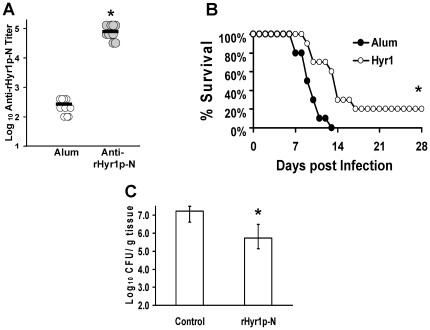
rHyr1p-N vaccine prolonged survival and decreased fungal burden in neutropenic mice infected with C. albicans.Balb/c mice (n = 20 per arm) were vaccinated with rHyr1p-N mixed with alum or alum alone (control), treated with cyclophosphamide, and then infected with C. albicans 15563 at 1×105 blastospores. Two days before cyclophosphamide treatment, half of the mice were bled and individually marked for antibody titer using ELISA (A) (rHyr1p-N vaccinated versus control, *P = 1.08E-05 by Wilcoxon rank-sum test) and survival (B) (rHyr1p-N vaccinated versus control, *P = 0.007 by log rank test). The other half mice were used for fungal burden (C) * P = 0.002 by Wilcoxon rank-sum test.